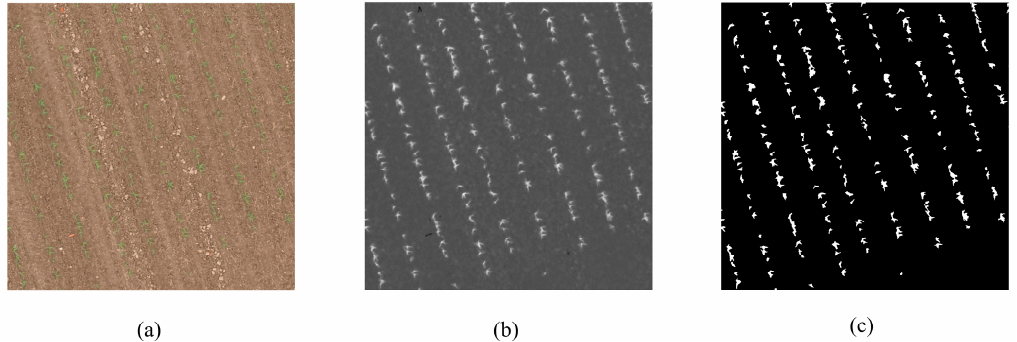
Figure 2. Separating plants from the background by the excess green (ExG) index and binary clustering: ( a ) Input image ( b ) ExG gray-level image, ( c ) binary clustered output of the ExG image.